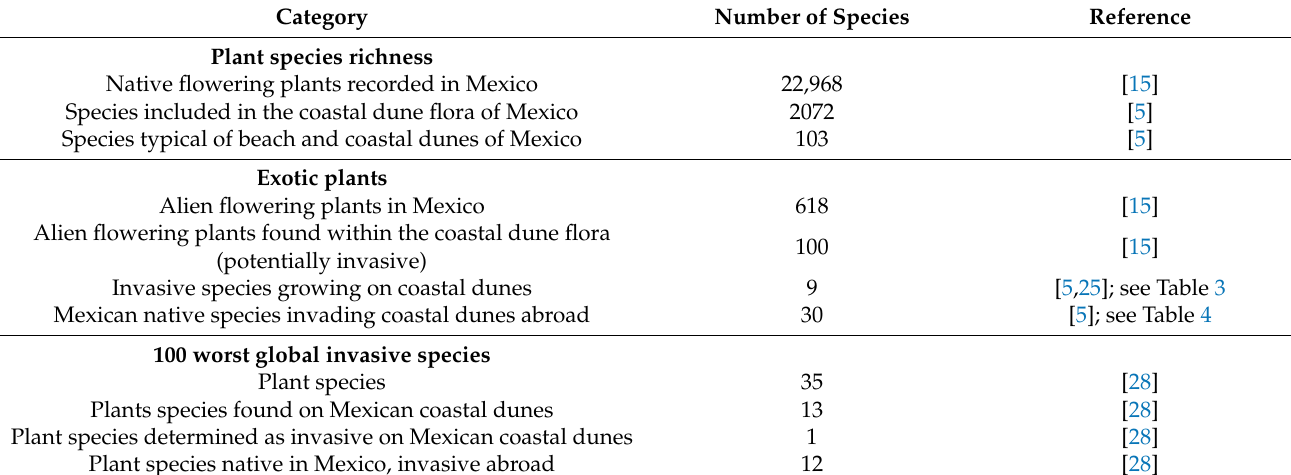
Table 1. Flora of Mexican coastal dunes and occurrence of exotic plants.